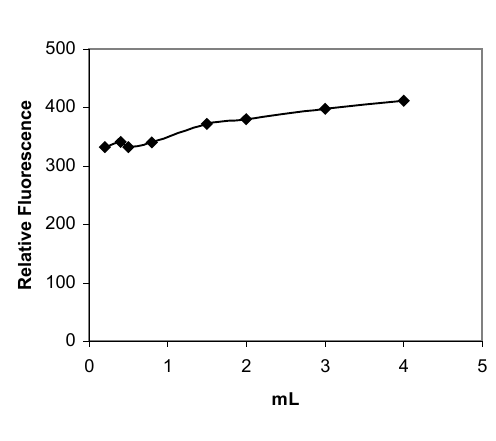
Figure 6. Effect of the volume of sodium triphosphate (2×10 -4 M) on the fluorescence intensity of Ce(III) with 0.216 μg mL -1